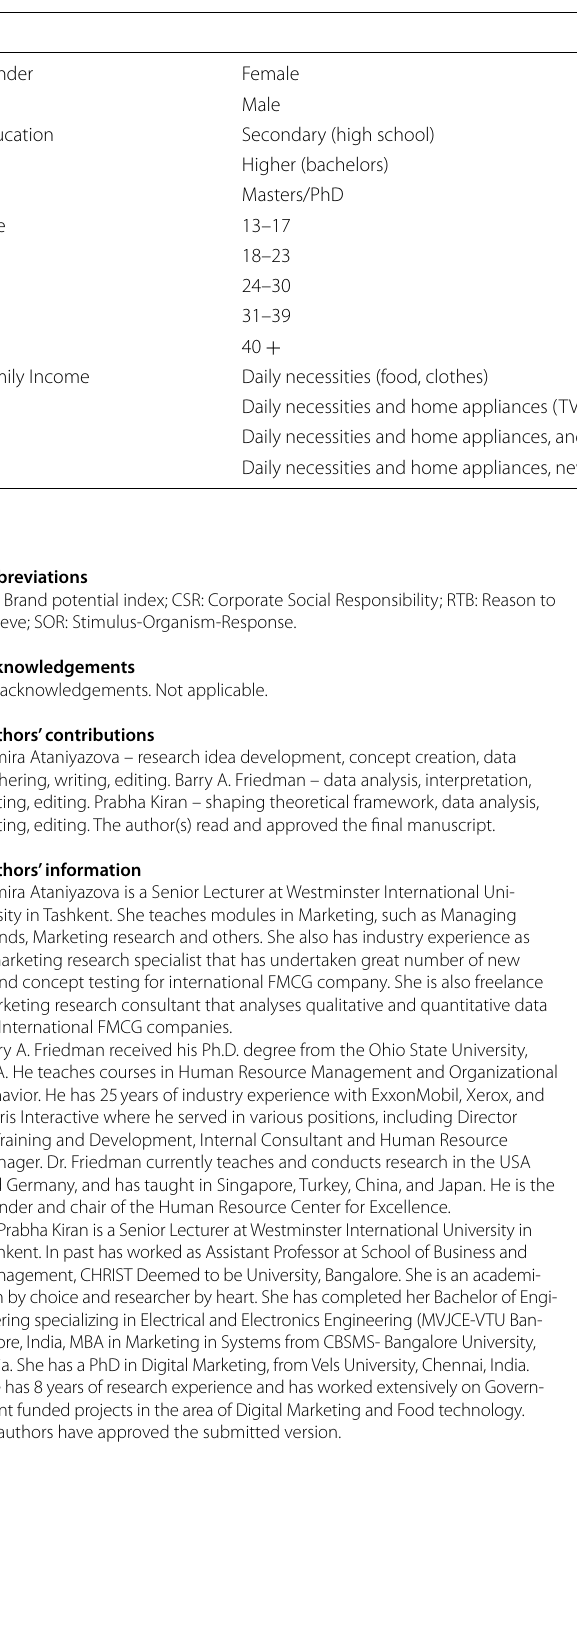
Table 4 Sample demographics: Gender, Education, Age, and Family